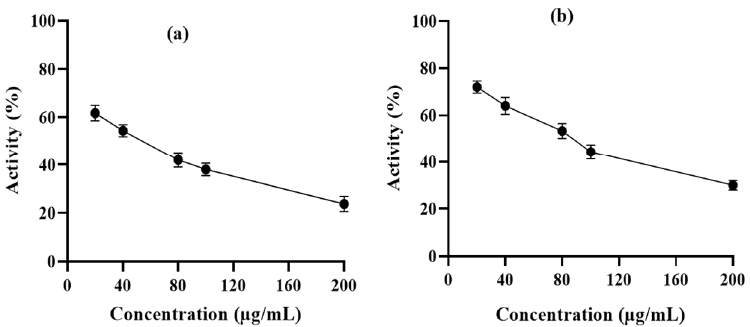
Figure 9. 6-PGD enzyme inhibition activity isolated by erythrocytes in the presence of ( a ) syrin- garesinol and ( b ) cleomiscosin A at various concentrations (20, 40, 80, 100 and 200 μ g/mL).